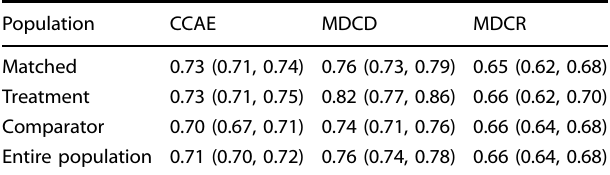
Table 2. Prediction performance. Discriminative ability (c-statistic) of the derived prediction models for acute MI in the matched set (development set), the treatment cohort, the comparator cohort, and the entire population in CCAE, MDCD, and MDCR. Values in parentheses are cross-validated 95% con fi dence intervals.